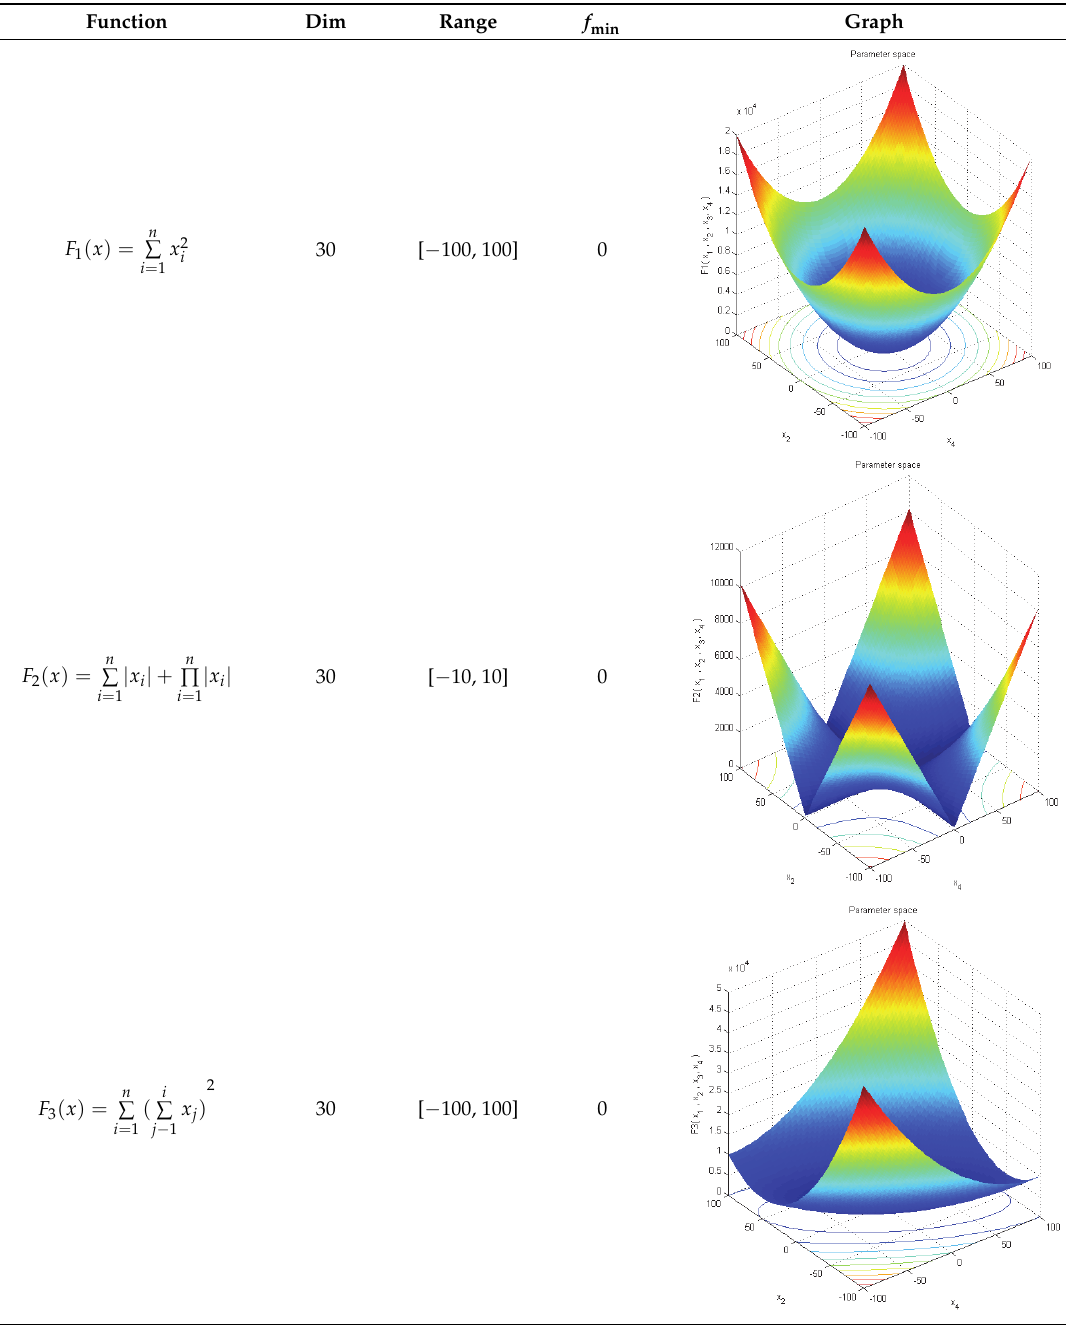
Table 1. Unimodal benchmark functions.